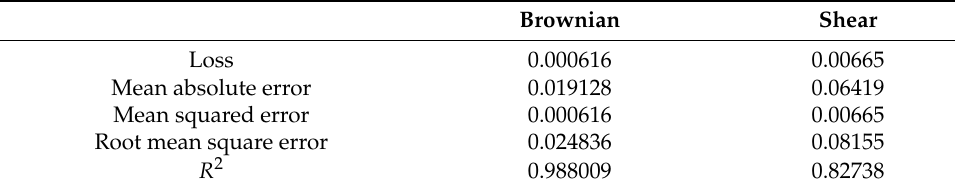
Table 5. Evaluation results of ANN models on the test dataset.